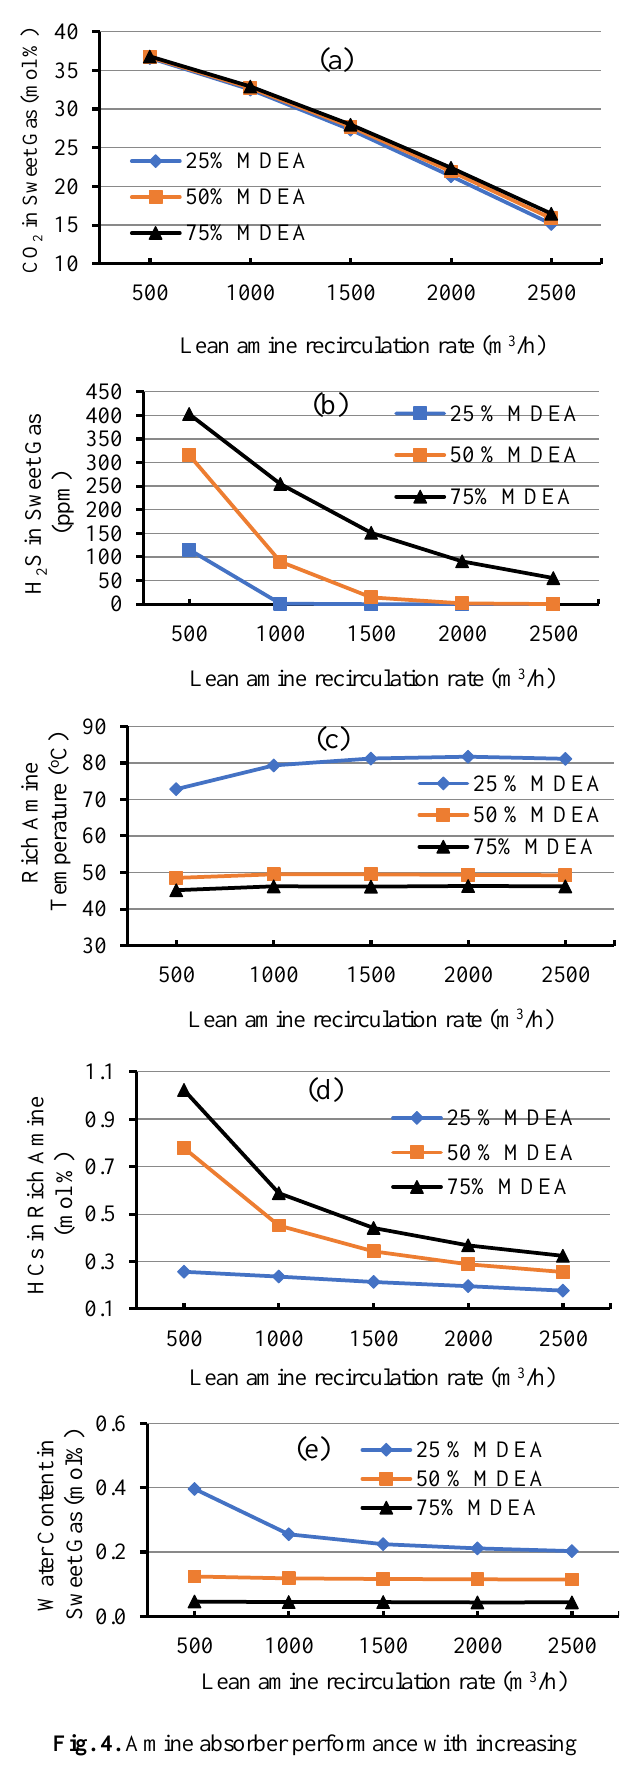
Fig. 4. Amine absorber performance with increasing recirculation rate and 25-50-75 mol% MDEA in aqueous solution at pressure drop of 34 kPaand 24